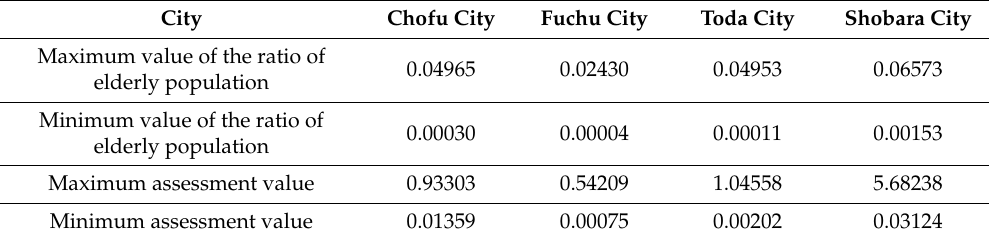
Table 7. Results with the ratio of elderly population as a weighted coe ffi cient.